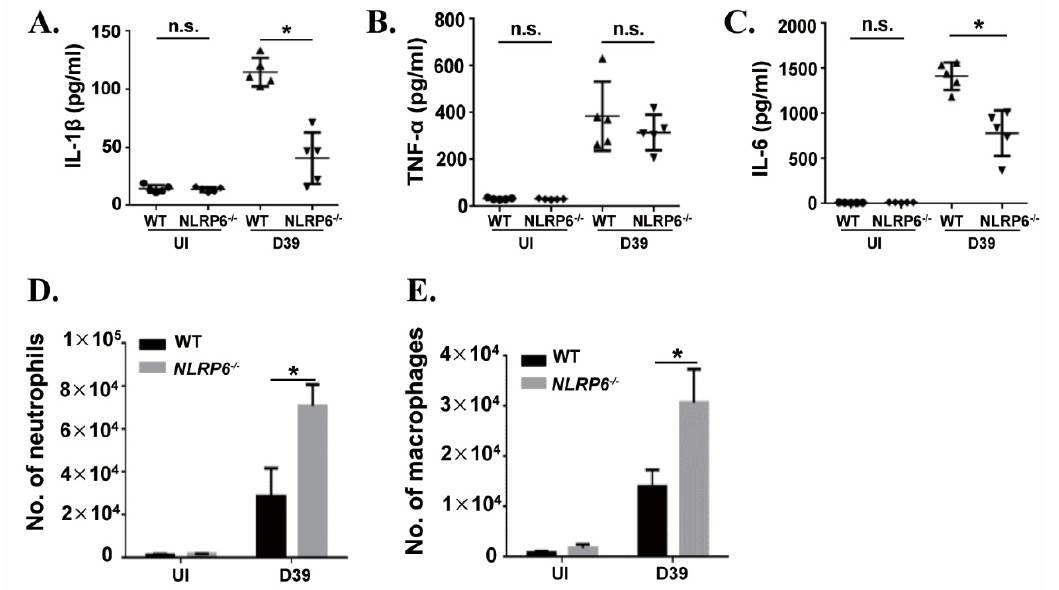
Figure 6. NLRP6 regulates S. pneumoniae -induced immune response in vivo. WT and NLRP6 − / − mice were uninfected or intranasally challenged with S. pneumoniae (5 × 10 7 CFU), and bronchoalveolar lavage fluid (BALF) was collected at 12 h post infection. The levels of IL-1 β ( A ), TNF- α ( B ), and IL-6 ( C ) were measured by ELISA ( n = 5). Quantification of the number of neutrophils ( D ) and the number of macrophages ( E ) ( n = 2–5) were determined by flow cytometry. Tests for statistical significance were performed using one-way ANOVA followed by the Bonferroni test (* p < 0.05).